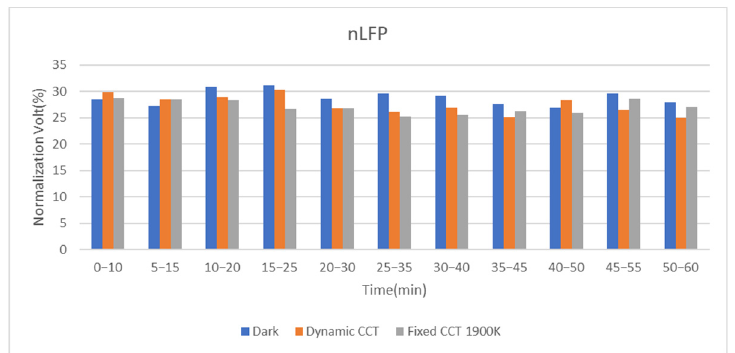
Figure 18. nLFP analysis.